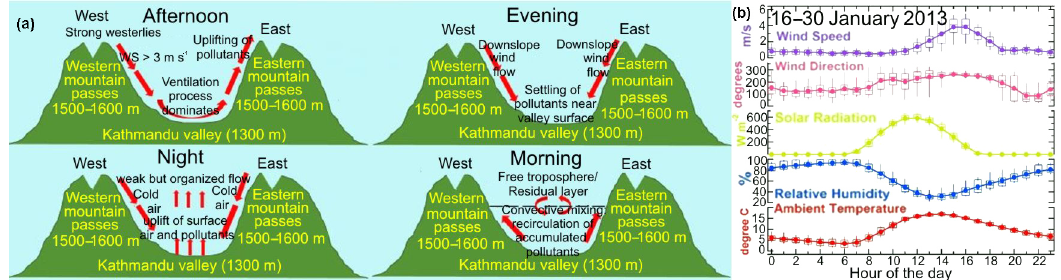
Figure 2. (a) Schematic of wind flow during different times of the day in the Kathmandu Valley. (b) Box and whisker plots of the measured meteorological parameters (wind speed, wind direction, solar radiation, relative humidity and ambient temperature) at the Bode site (16– 30 January